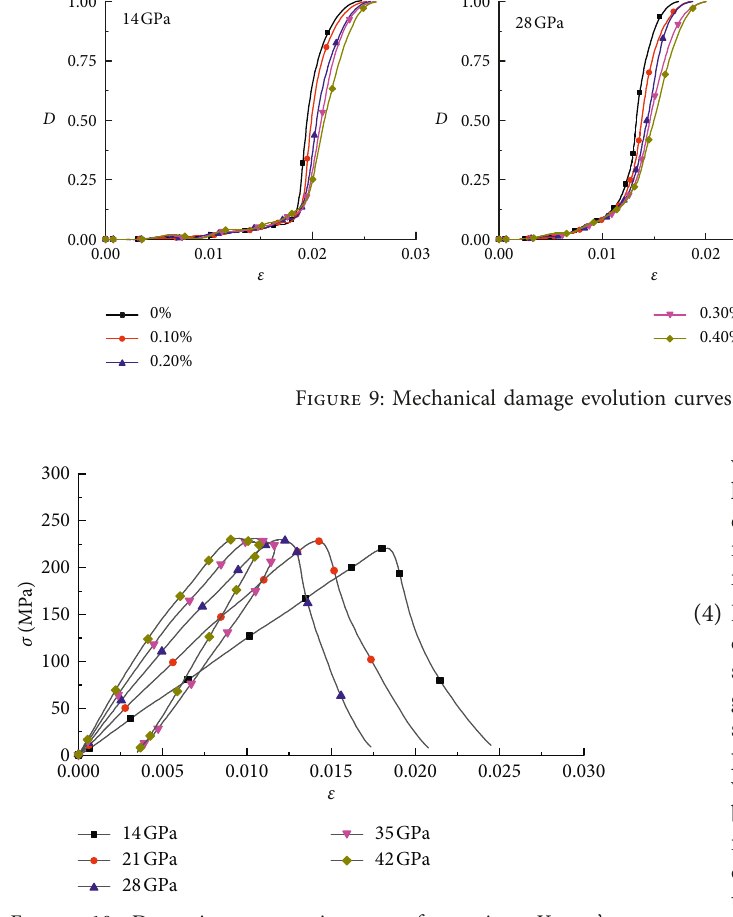
Figure 10: Dynamic stress-strain curve for various Young’s